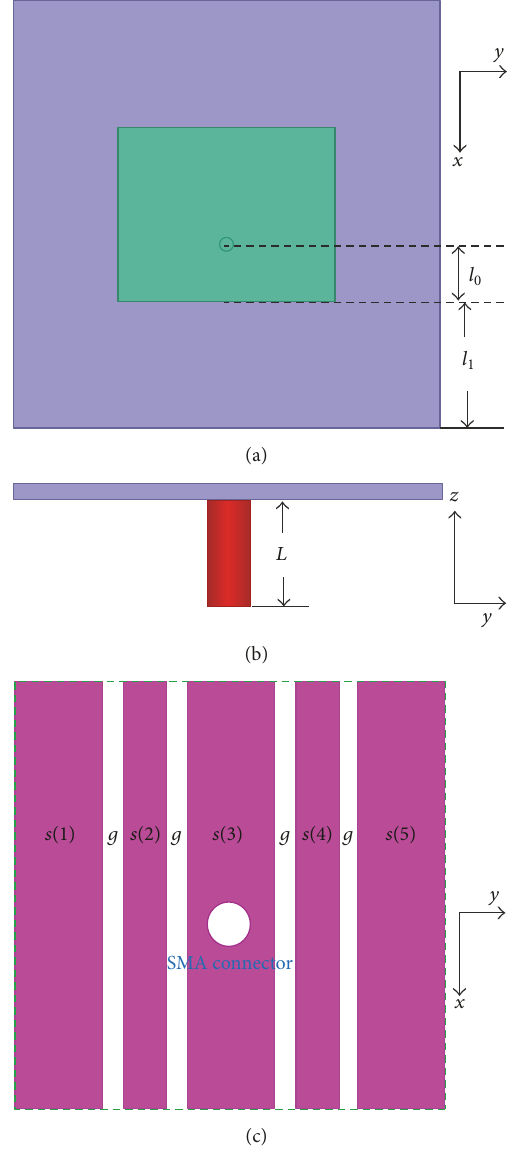
Figure 1: The overall view of the strip-ground antenna. (a) Front view of the patch. (b) Side view of the model. (c) Front view of the sliced ground